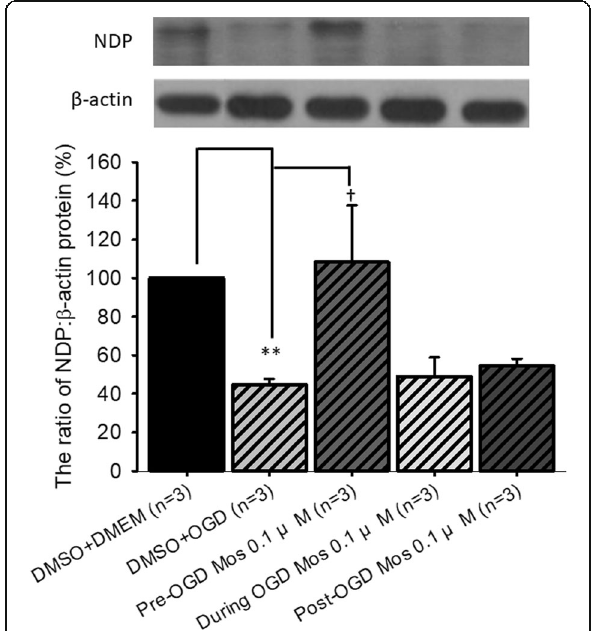
Fig. 2 The effect of moscatilin on the protein expression levels of NDP relative to β -actin. Top: a series representative immunoblotting images. Bottom: bar chart. The protein expression level of NDP vs. β -actin in the normal control (DMSO+DMEM: RGC-5 cells cultured in DMEM and pre-administration of DMSO) was adjusted to 100%. ** indicates a significant difference ( P <0.01) between the “ DMSO+DMEM ” group and the “ DMSO+OGD ” group. † indicates a significant difference ( P =0.048) between the “ DMSO+OGD ” and “ Pre-OGD 0.1 μ M Mos ” groups (0.1 μ M moscatilin given 1 h pre-OGD). The results are presented as means±S.E.M. ( n =3). Please refer to definitions of various groups in Table 1. Abbreviations: NDP, Norrie disease protein; DMSO, dimethyl sulfoxide; DMEM, Dulbecco ’ s modified Eagle ’ s medium; OGD, oxygen glucose deprivation; RGC, retinal ganglion